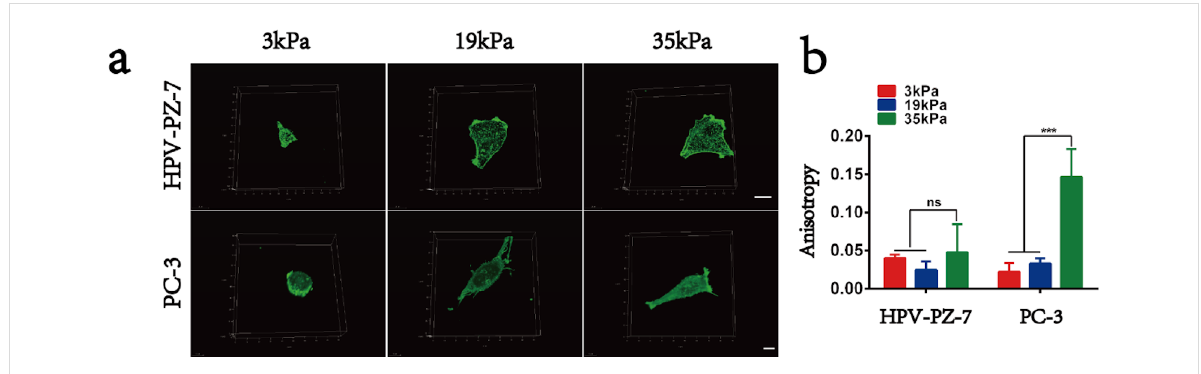
Figure 4: Cytoskeletal microfilaments respond to changes in substrate stiffness on prostate cancer cells. (a) Fluorescence images of HPV-PZ-7 and PC-3 cytoskeletal microfilaments of cells seeded on substrates with different stiffness. The scale bar of HPV-PZ-7 cells is 20 μ m and the scale bar of PC-3 cells is 10 μ m. (b) Anisotropy quantification maps of the fibrillar structure of HPV-PZ-7 and PC-3 cells on substrates with different stiffness. FibrilTool, an ImageJ plug-in, was used to quantify the fibrillar structure in the original cytoskeleton images. Anisotropy (score between 0 and 1): 0 for no order (purely isotropic arrays) and 1 for perfectly ordered arrays (i.e., parallel fibrils, purely anisotropic arrays); “ns” means no difference, *** P <